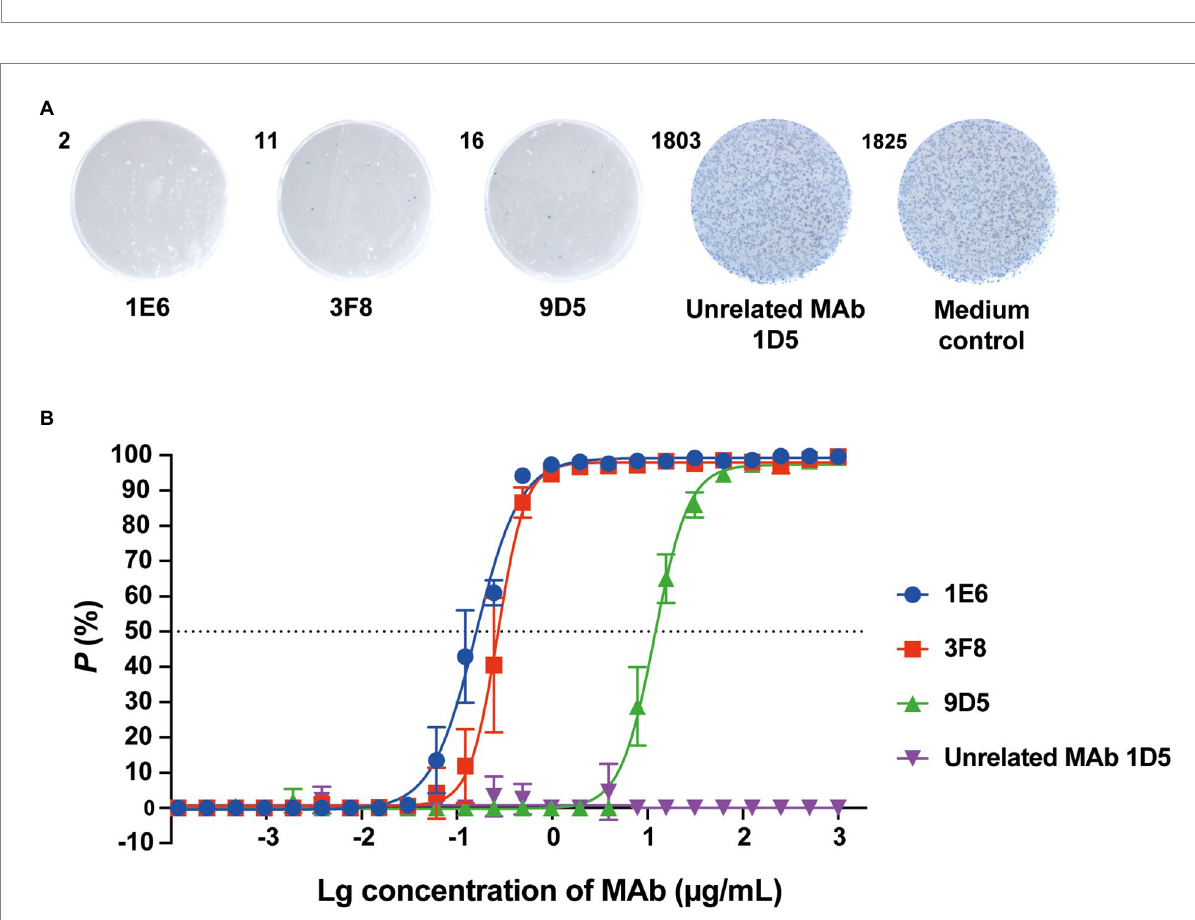
FIGURE 6 Screening of anti-RV-C15 neutralizing antibodies using Nt-ELISPOT. (A) Representative cell wells of anti-RV-C15 neutralizing antibodies, named 1E6, 3F8, and 9D5, screened by Nt-ELISPOT are shown. Unrelated MAb 1D5 (Xu et al., 2017) and medium groups were served as controls. The RV- C15-infected cells were labeled in blue with HRP-9F9. (B) The IC 50 values of the NAbs were calculated by the Nt-ELISPOT. The NAbs 1E6, 3F8, and 9D5 were 2-fold serially diluted for neutralization testing. Unrelated MAb 1D5 was served as a control which showed no significant neutralization efficacy. Each of the dilutions was performed in triplicate. The error bars indicate the mean ± SD from three independent experiments.